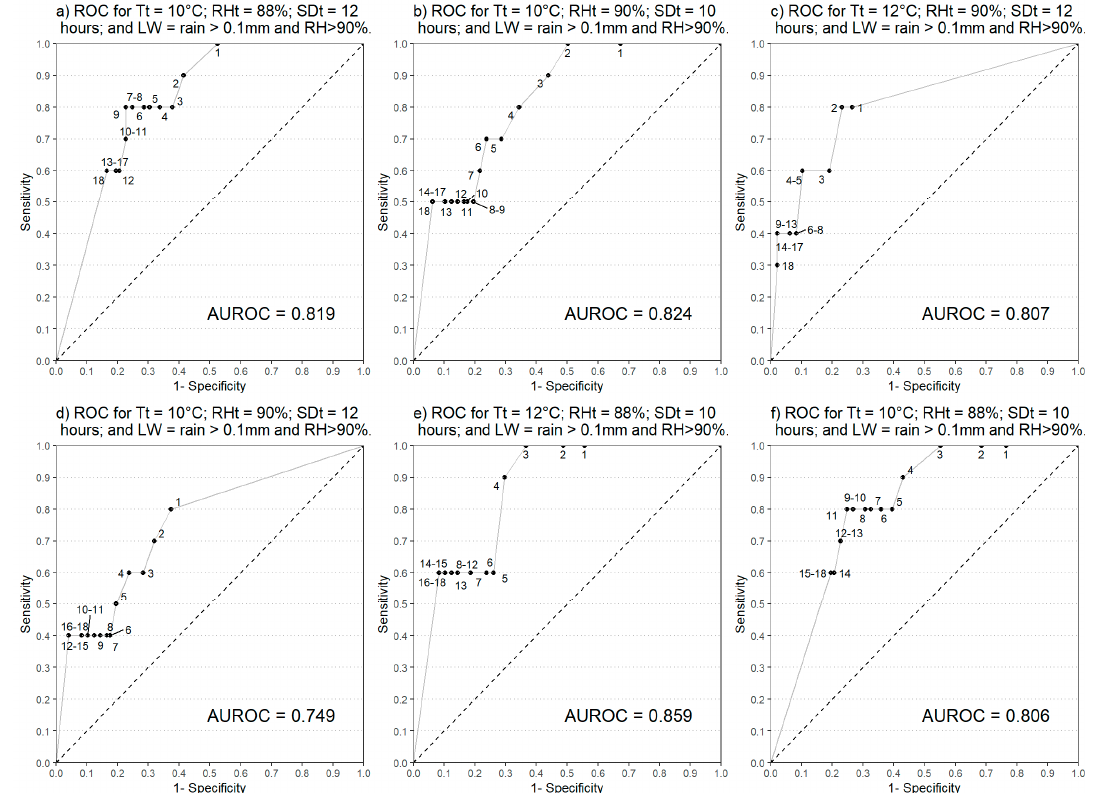
Figure 6. ROC curves for the model parameterizations according to the results of the sensitivity analysis. The IR model parameterizations with the change in a single model variable threshold: relative humidity ( a ), sporulation duration ( b ) and the sporulation duration ( c ), followed by the default ( d ), optimized ( e ) and low risk ( f ) model parametrization.